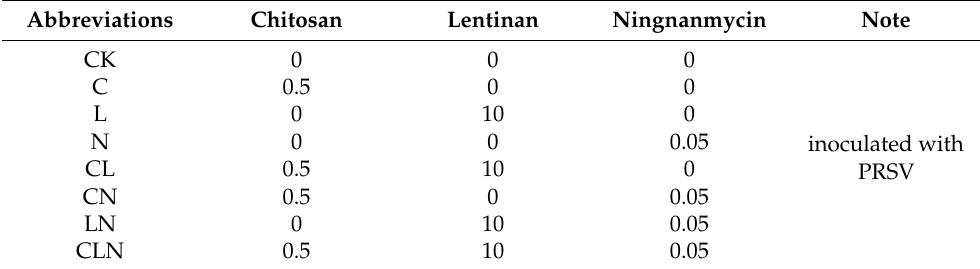
Table 1. The experiment design of controlled effect of Chitosan, Lentinan, Ningnanmycin on PRSV (g L − 1 ) in the above